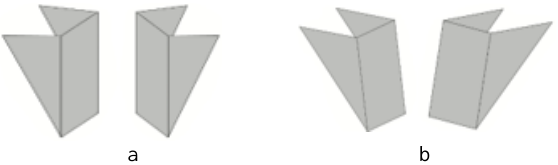
Figure 15. 3D models of abutment elements for: a: bridge 1; and b: bridge 2.